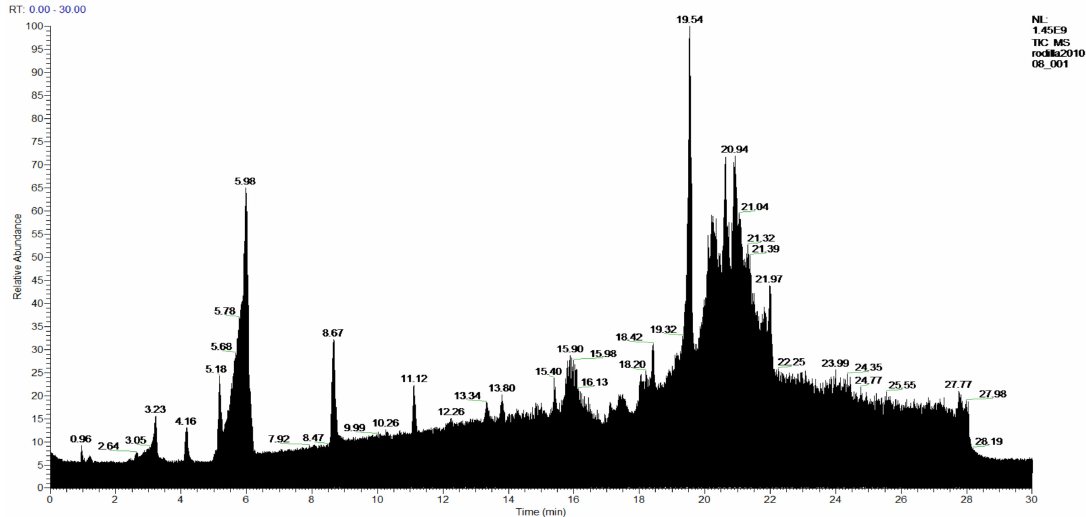
Figure 10. Chromatogram of 1-Chloroform extract from P. hypoleucinum .